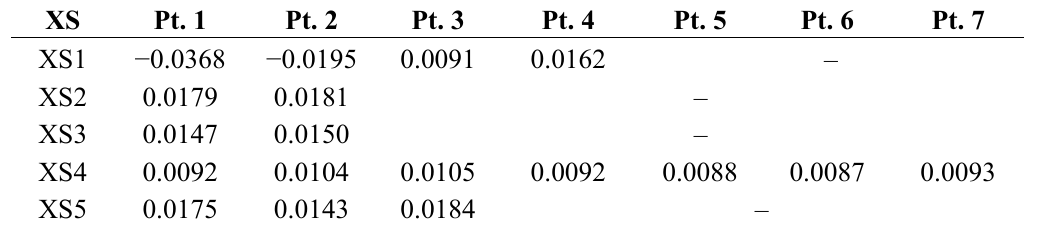
Table 1. Two-dimensional velocity at measuring point (Pt.) in each cross section (XS) (m/s).